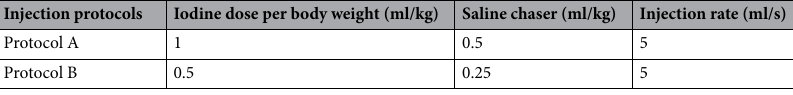
Table 1. Contrast injection protocols.